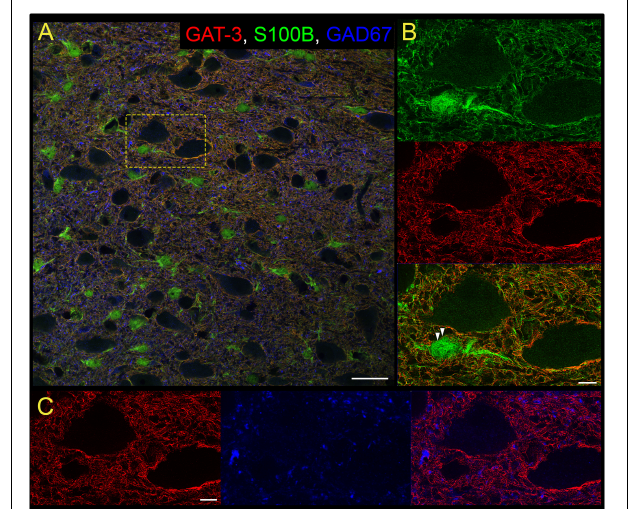
FIGURE 2 | Gamma-aminobutyric acid transporter 3 is found on nTS astrocytes. (A) Overview of immunoreactivity of GAT-3 (red), astrocyte S100B (green) and GABAergic GAD67 terminals (blue). Dashed box is shown in (B,C) . Scale, 25 µ m. (B) Super-resolution image of S100B and GAT-3, and their overlay, demonstrating GAT-3 aligns with S100B. Arrowheads denote GAT-3 on the membrane of S100B-labeled astrocyte somas. Scale, 5 µ m. (C) GAT-3 surrounds GAD67-labeled GABA terminals (arrow). Scale, 5 µ m. Shown are single optical sections.